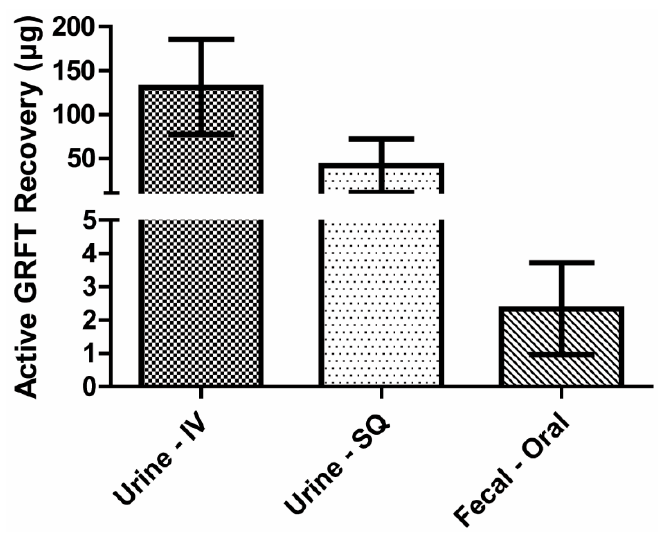
Figure 4. Total GRFT recovery following single administration. Based upon the likely route of excretion, urine or fecal samples were obtained from animals treated with 10 mg/kg GRFT intravenously (IV), subcutaneously (SQ), and orally. GRFT amounts in respective samples were determined. Bars indicate mean ± standard deviation from five biological replicates.